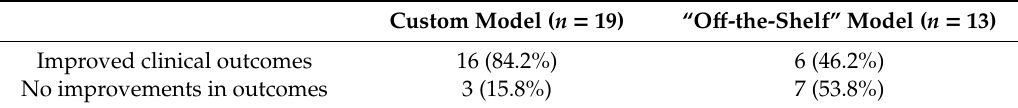
Table3. Distributionofstudiesregardingsourceofpredictivemodelandimprovementinclinicaloutcomes after implementation. Only studies that reported evaluations of effects of model implementation on clinical outcomes are included in the table.